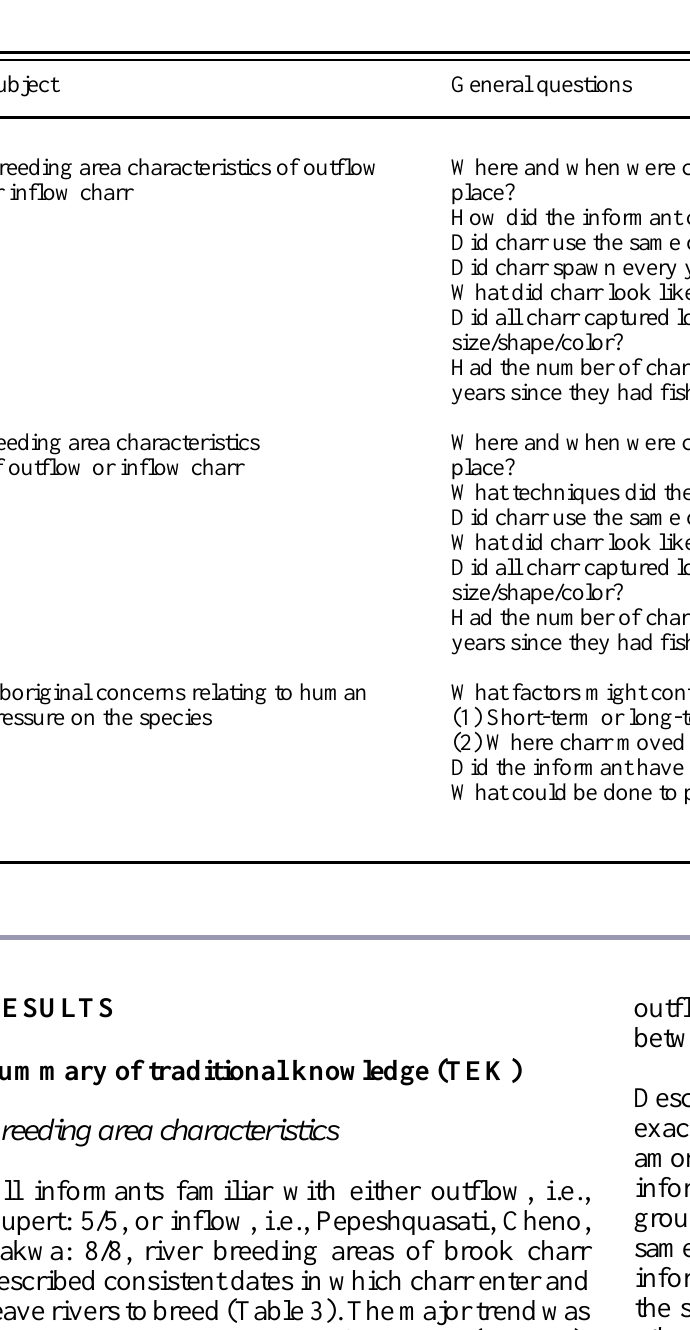
Table 2. The general series of questions used as a guide for semidirective